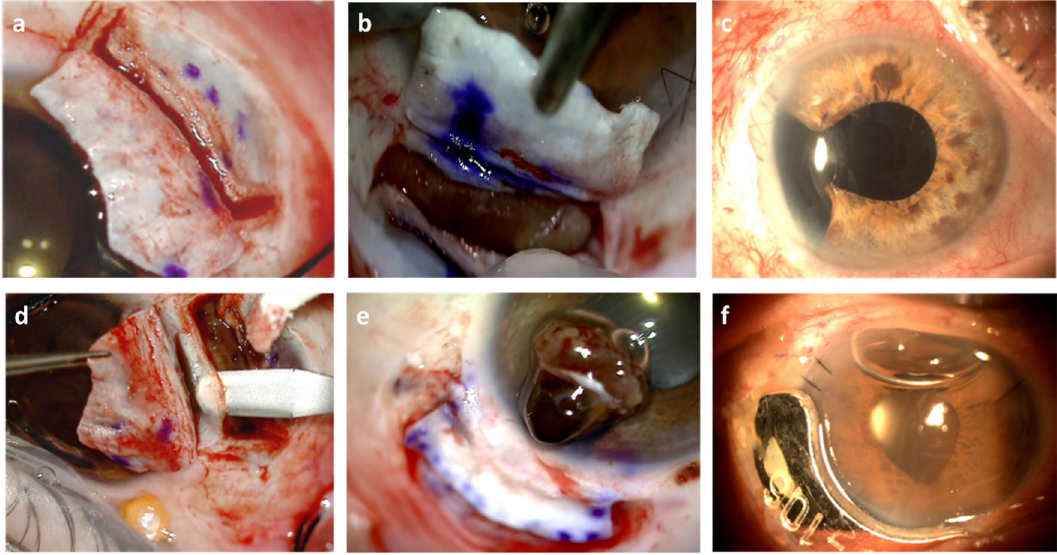
Figure 2. Images of the surgical field showing: ( a ) double flap in smaller tumors to avoid thinning of the sclera; ( b ) double flap, with diodopexia applied; ( c ) pupiloplasty+ sector ring to avoid photo- phobia; ( d ) if technically possible, and no significant invasion is likely, we try to maintain the scleral spur to reduce astigmatism; ( e ) exoresection of iris melanoma with spur invasion; ( f ) Ru-106 over the surgical exoresection bed.